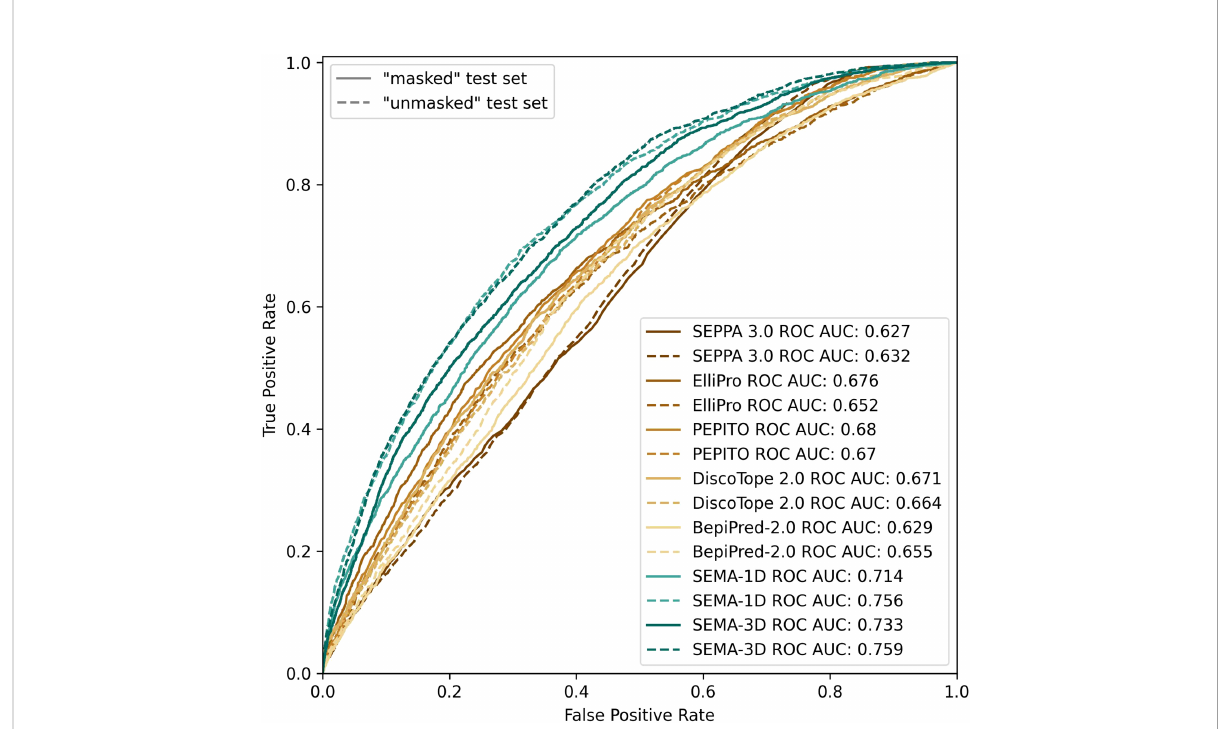
FIGURE 4 ROC AUC metrics calculated using peer methods, SEMA-1D and SEMA-3D on two test sets: “ masked ” ( R 1 = 4.5 Å; R 2 = 16.0 Å) and “ unmasked ” ( R 1 = 4.5Å; R 2 = in fi nite ).